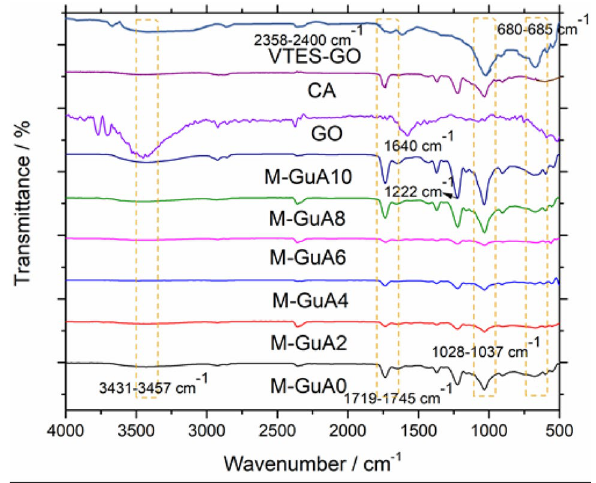
Figure 1. FTIR spectra of GO, CA, VTES-GO, and M-GuA